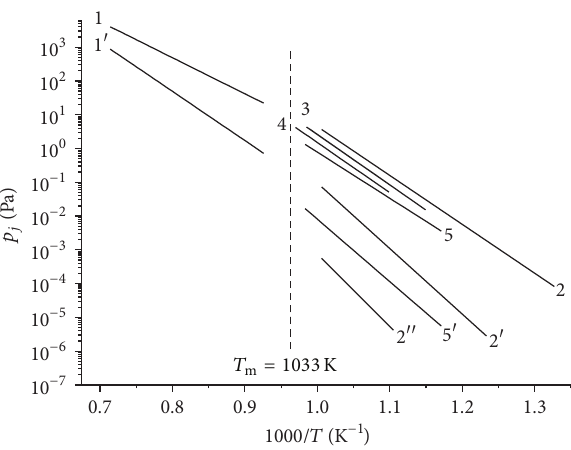
Figure 5: Temperature dependencies of the saturated vapor pres- sure: ( 1 ) p (CeI 3 ) from [9], ( 2 ) our data, ( 3 ) [2], ( 4 ) [7], and ( 5 ) [6]; (1 󸀠 ) p (Ce 2 I 6 ) from [9], (2 󸀠 ) our data, and (5 󸀠 ) [6]; ( 2 󸀠󸀠 ) p (Ce 3 I 9 ) our